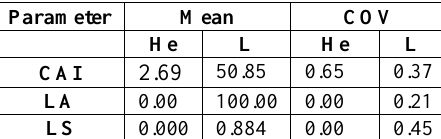
Table 1. Summary statistics of measured parameters for He and L samples. COV is the coefficient of